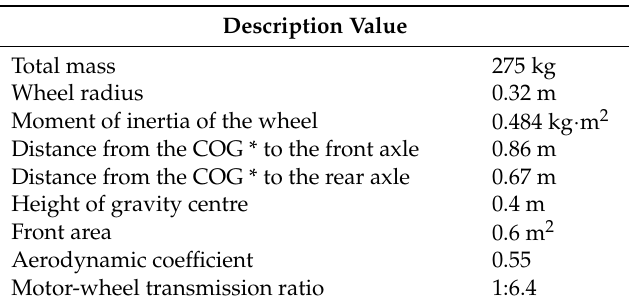
Table 3. Motorcycle model parameters.